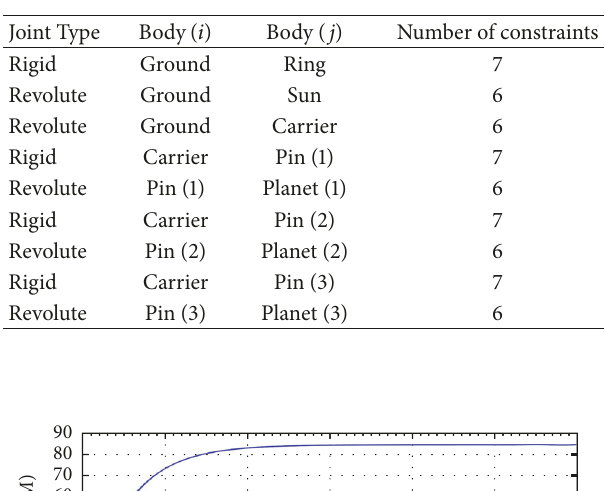
Table 4: Holonomic constraints of stage (1).